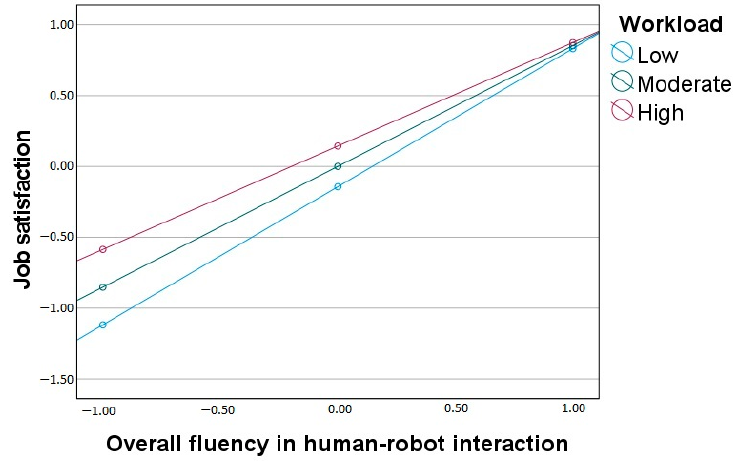
Figure 4. Workload as a moderator between overall fluency in human-robot interaction and job satisfaction.